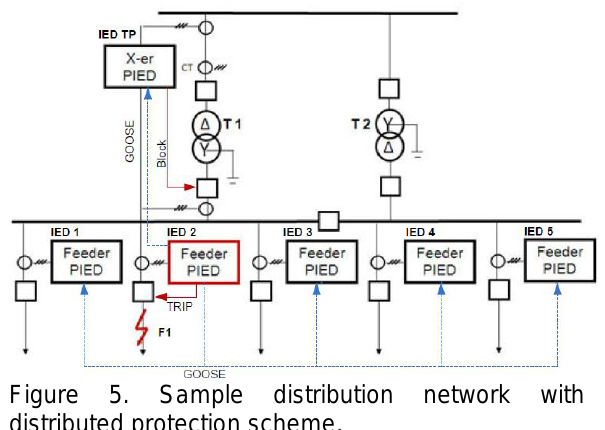
Figure 5. Sample distribution network